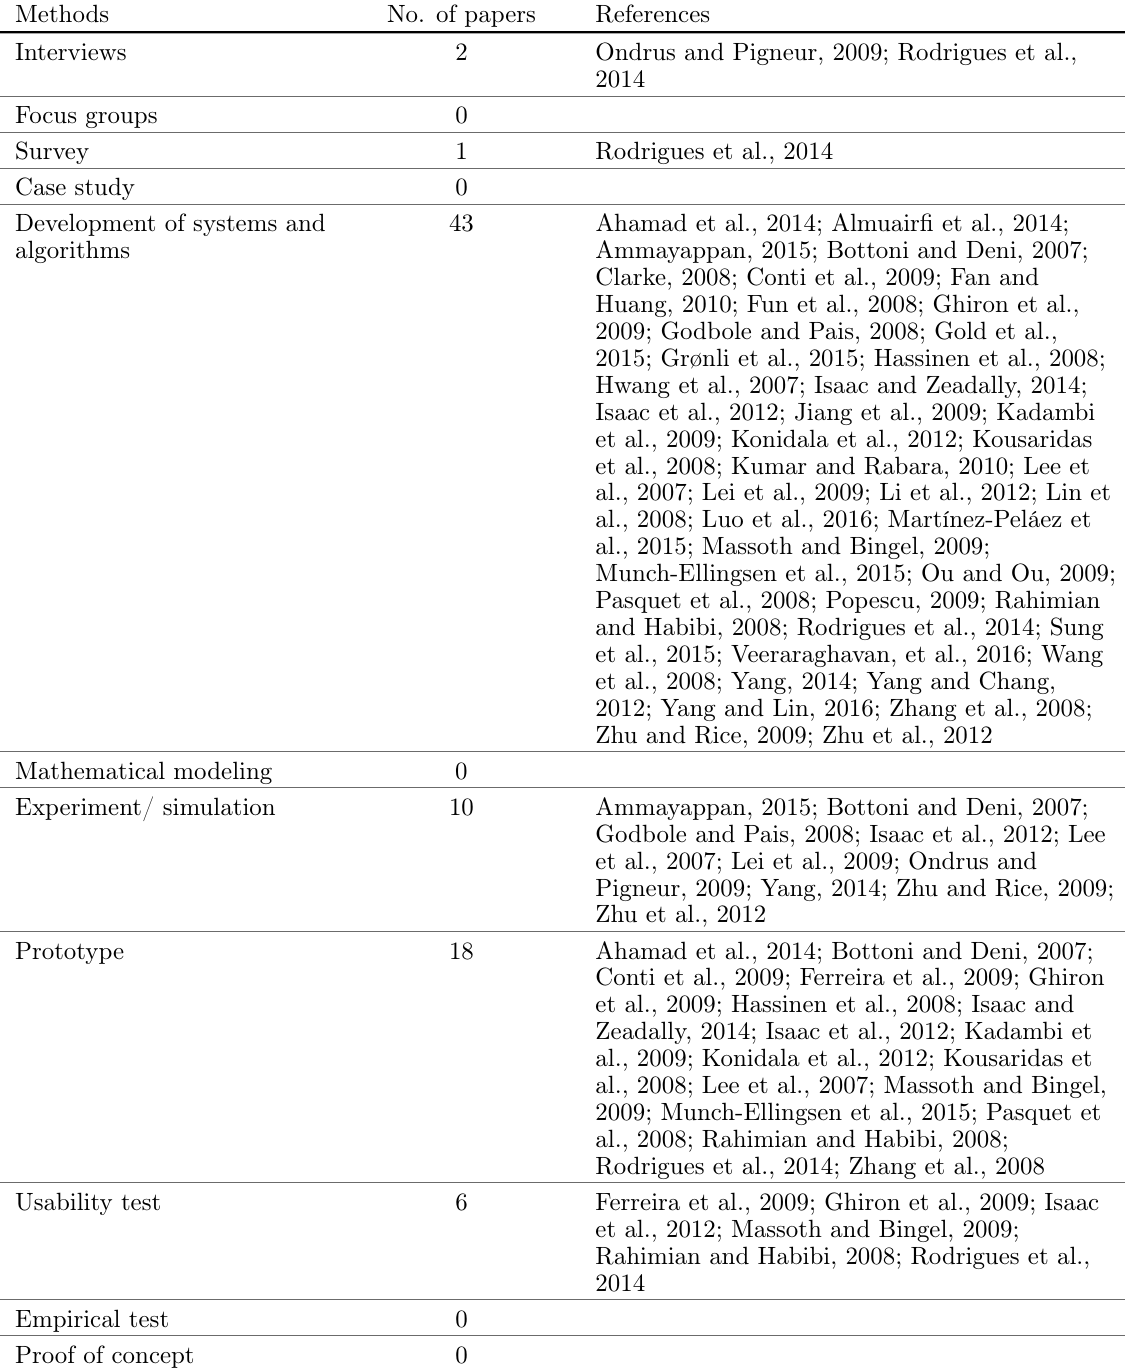
Table B.3 . Research methods used in studies on mobile payments’ business aspects.